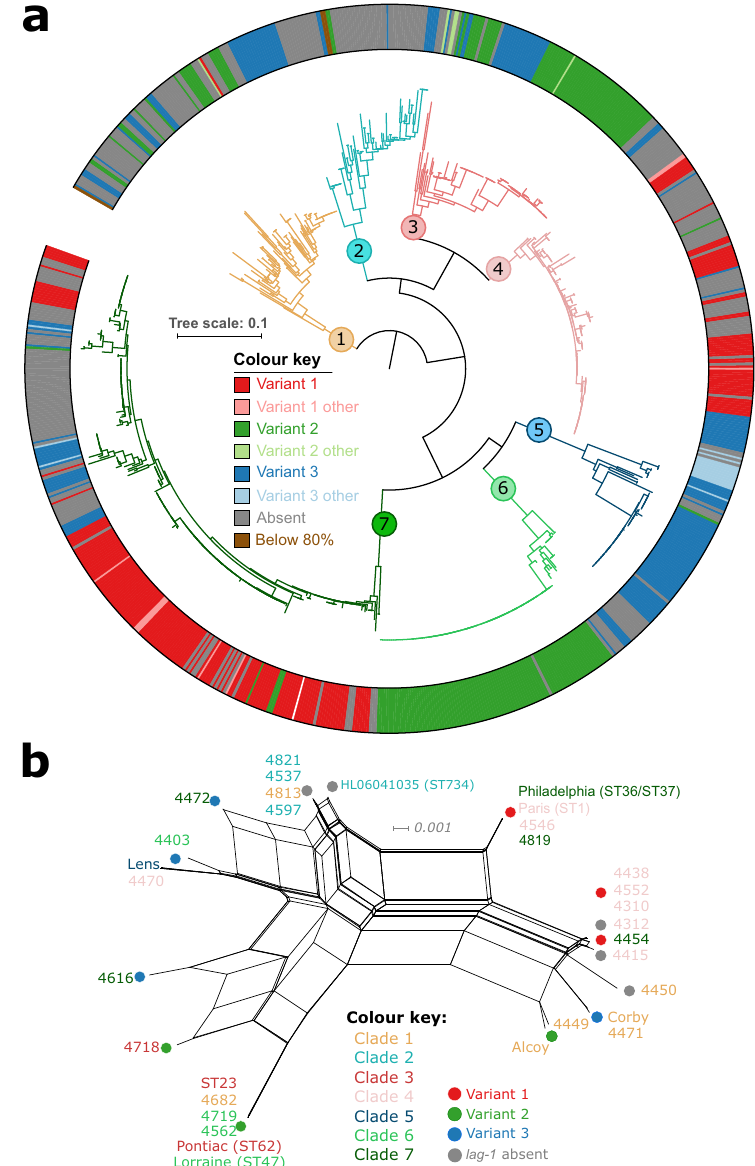
Fig. 3 lag-1 variants have disseminated horizontally across the species. a Core-genome SNP-based phylogenetic tree indicating the distribution of the 3 major allelic variants of lag-1 across Sg-1 strains. Variant 1 (Philadelphia, Red), Variant 2 (Arizona, Green) and Variant 3 (Corby, Blue). Each major clade is associated with at least two different lag-1 alleles. Minor alleles that are within >99% nucleotide sequence identity to a major variant are shown with lighter colours. Isolates not containing lag-1 are coloured grey. The tree scale indicates the number of subtitutions per site. b A neighbour-net phylogenetic network indicating recombination of Sg-1 LPS genes including lag-1 . The network was drawn using uncorrected P-distances with the equal angle method in Splitstree from a concatenated alignment of 10 conserved Sg-1 LPS genes that were signi fi cantly associated with clinical isolates (9405 positions). Orthologs of 10 LPS cluster genes were extracted from 16 phylogenetically representative isolates coding 3 different variants of lag-1 , 7 isolates missing lag- 1 and 9 reference genomes (Lens, HL06041035, Philadelphia-1 [ST36], Paris [ST1], Corby, Alcoy, Pontiac [ST62], Lorraine [ST47], pressure for the conservation of lag-1 sequence and function. The nucleotide sequence identity of 89% – 95% between the three allelic variants is lower than the average nucleotide sequence identity for genes across the species, which is typically >95% (Supplementary Table 2). The closest homologue of lag-1 in the NCBI non-redundant protein database shares only 45% amino acid sequence identity and encodes a putative acyltransferase present in an environmental species of the genus Pseudomonas .